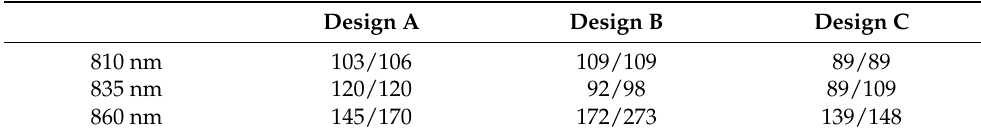
Table 2. Spectral resolution limit with curved/flat detector (in